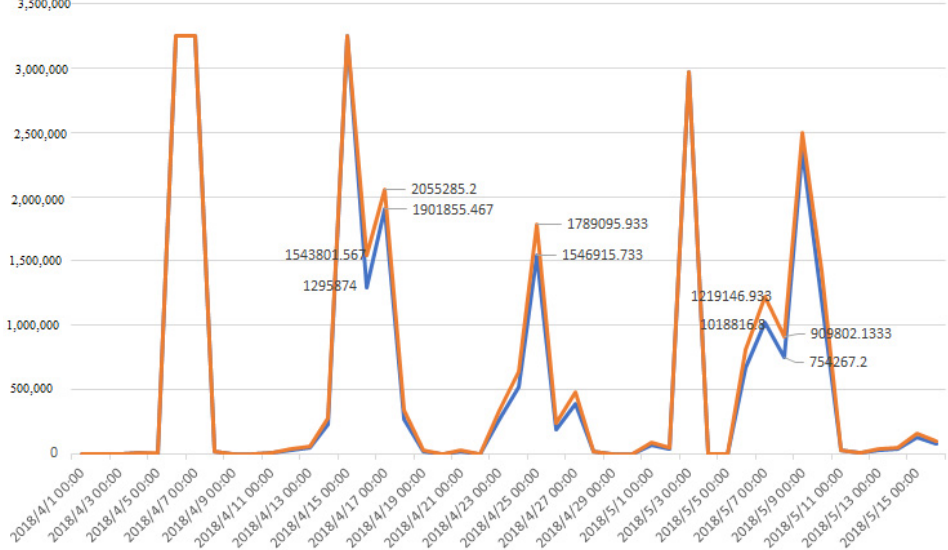
Figure 18. Wind velocity chart between 1 April and 16 May in 2017.